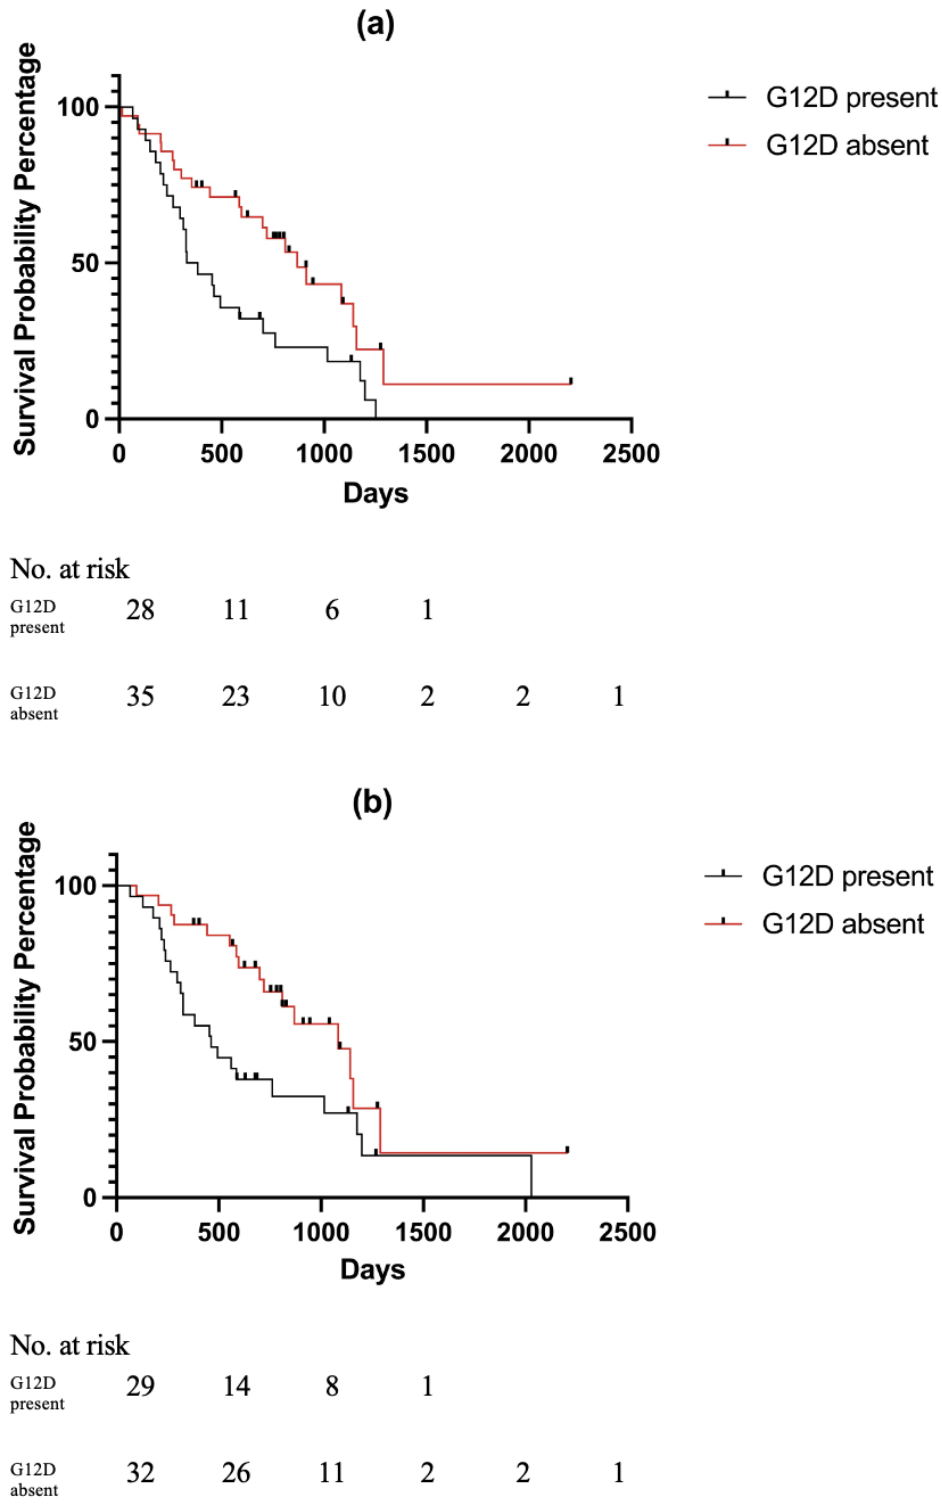
Figure 1. Kaplan Meier curves and respective numbers at risk. G12D subtype associated with poorer survival in patients NCCN staged as resectable. ( a ) G12D subtype associated with poorer survival in patients NCCN staged as operable. ( b ) G12D subtype associated with poorer survival in patients who received surgery. G12D absent includes both other KRAS subtypes and KRAS wild-type. Similarly, with respect to the treatment modality, there was also no statistically sig- nificant difference in overall survival between KRAS mutant and wild-type patients in patients in any of the treatment groups: surgery, chemotherapy/radiotherapy and best